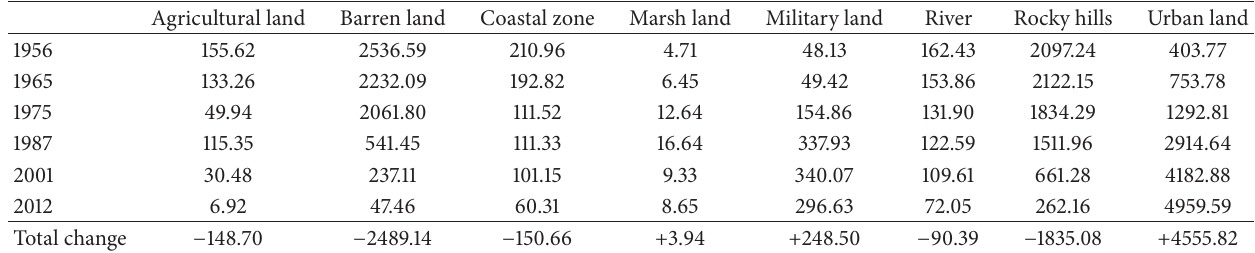
Table 4: Land use classes changes during studied time periods (hectares).